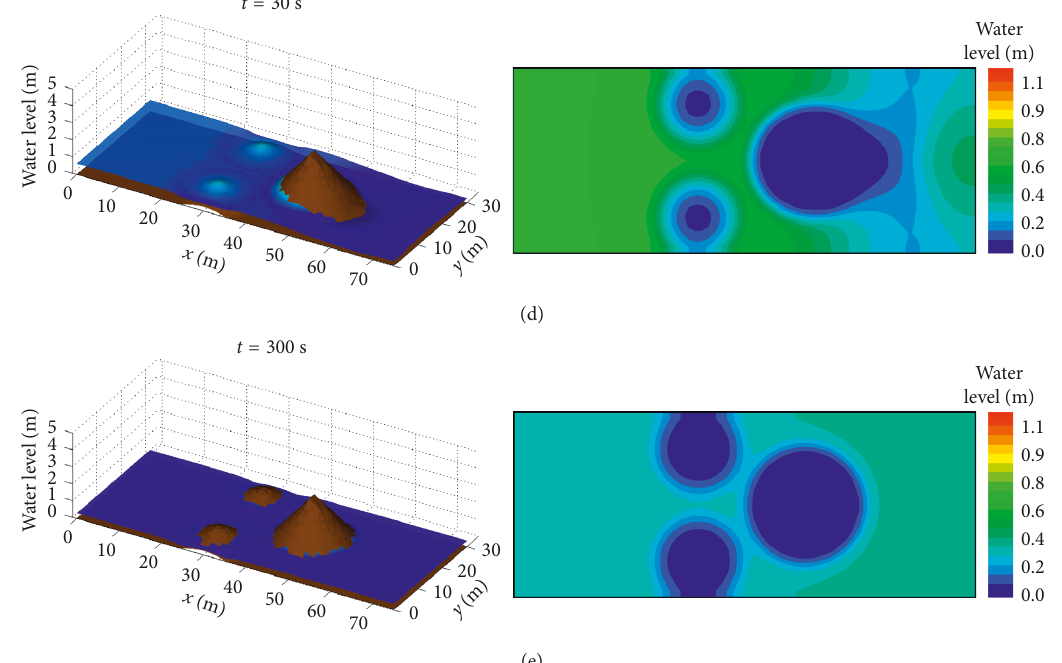
1s, t 6s, t 12s, (cid:29) (cid:29) (cid:29)